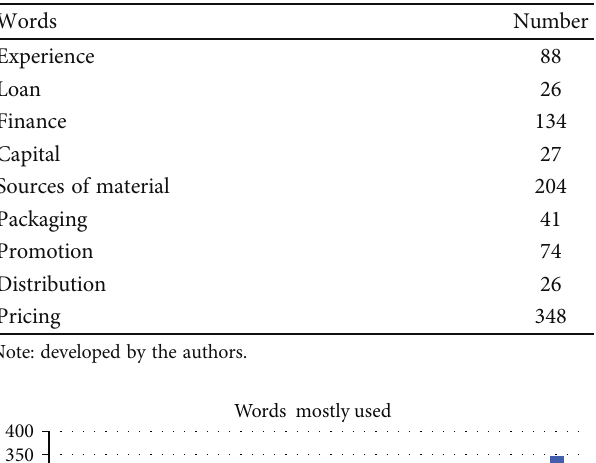
Table 2: Words mostly used in FB community of entrepreneurs.